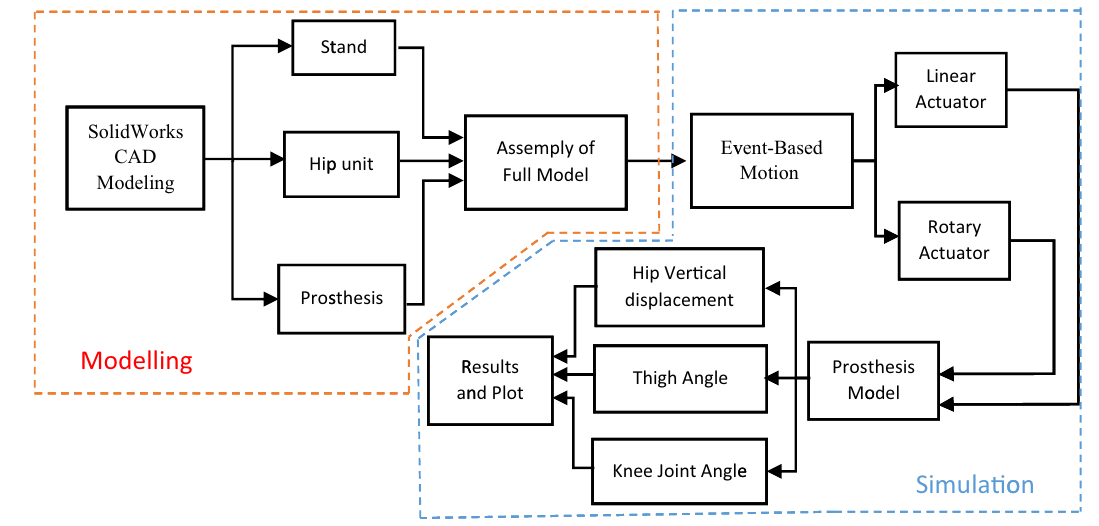
Figure 2: Schematic of